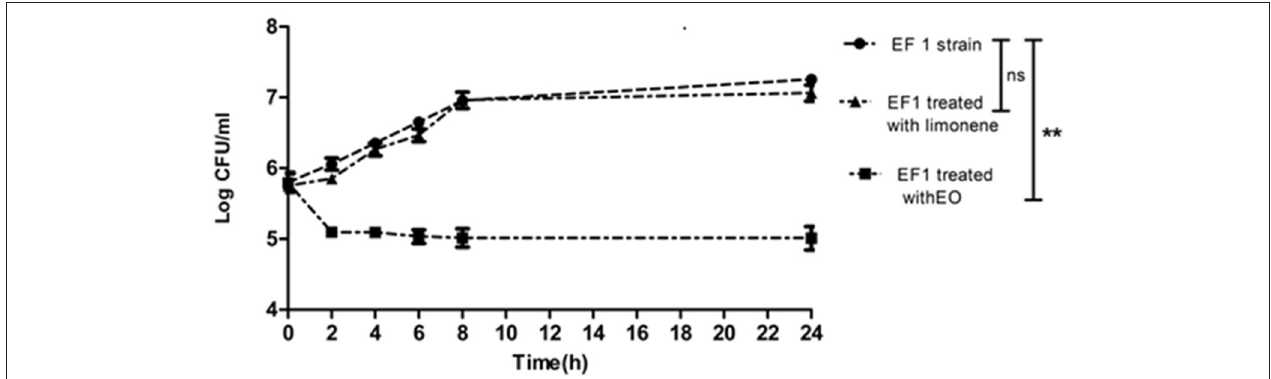
FIGURE 1 | Bacterial counts of EF1 isolate after MIC of EO and limonene at concentration that showed the best inhibitory effect against EF1. ** p < 0.01 compared with EF1 alone. Each value represents means ± SD.